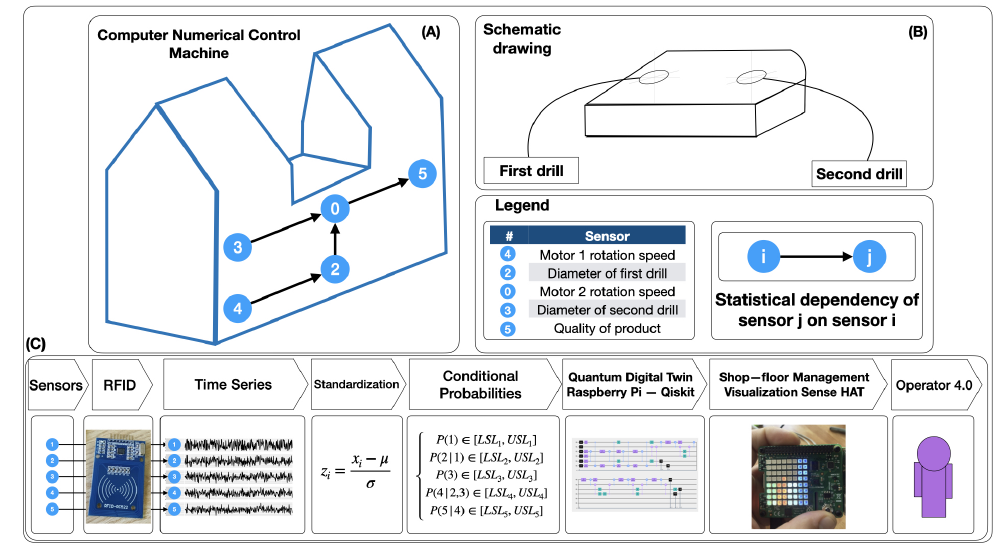
Figure 1. Scheme of our Quantum JIDOKA case study: the digital quantum twin to provide the 4.0 operator with a shopfloor management tool that allows him to visualize the status of the machine in real time. ( A ) CNN-machine and schematic sensor network. ( B ) Schematic product drawing. ( C ) Quantum ( 自 働 化 ) creation